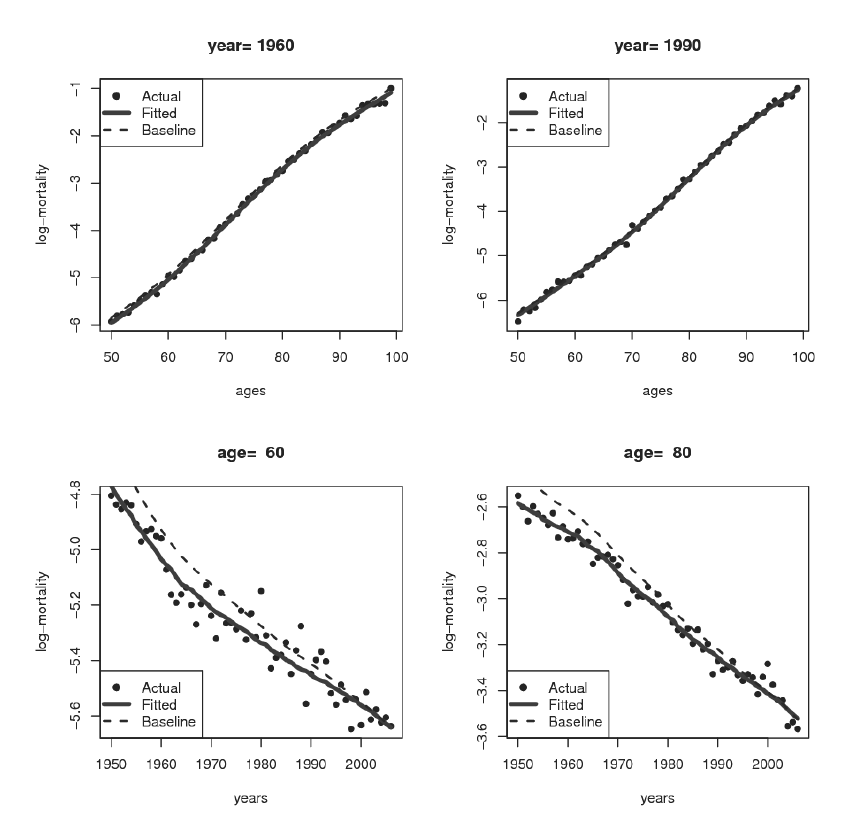
Figura 7 – Observed and fitted mortality rates for selected years and ages. Ip = H and Ic = m 1-4 . Swe- den,